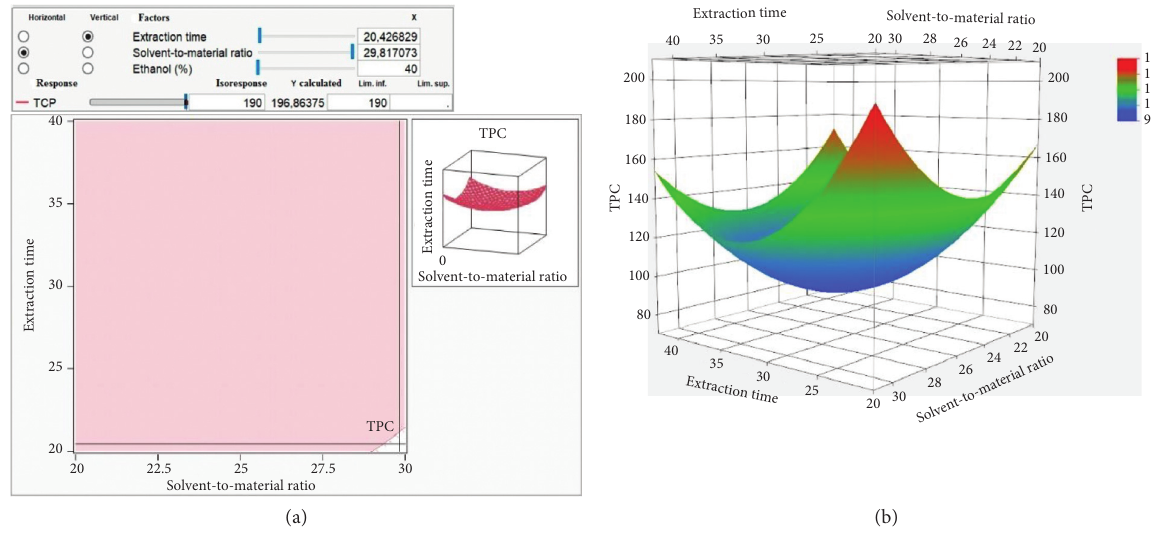
Figure 5: (a) Isoresponse plot showing the optimal compromise zone leading to the desired TPC (190mg EAG/g) obtained by fixing the third parameter (ethanol (%)) in its low level (40%) and varying the other two parameters. (b) 3D plot of the response TPC in terms of extraction time and liquid/solid ratio effects and by fixing the concentration of ethanol at